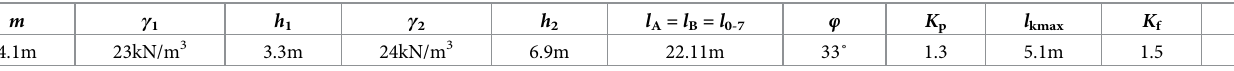
Table 4. Calculation parameters of SSC in No.7 coal